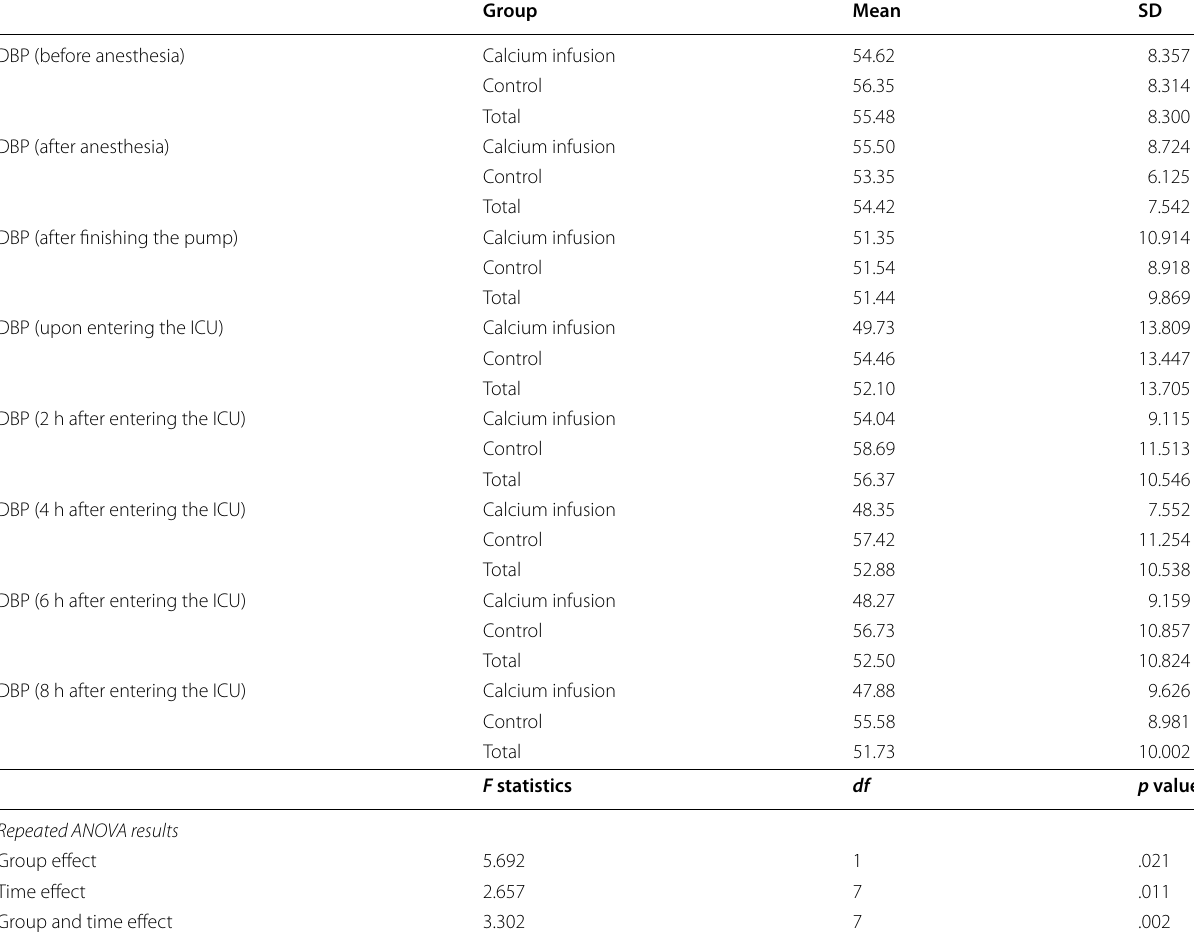
Table 4 Statistics of diastolic blood pressure